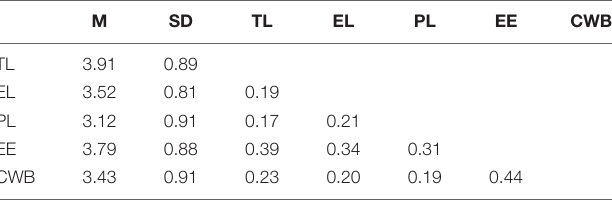
TABLE 1 | Means, standard deviations, and correlation ( N =